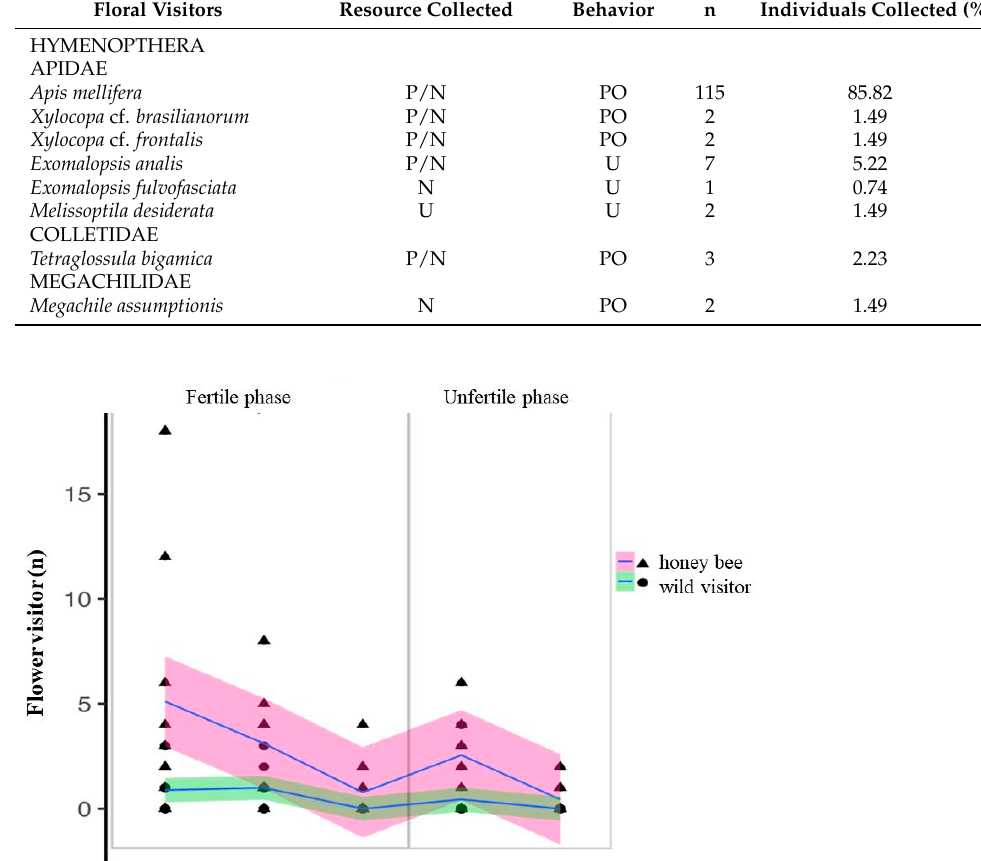
Table 1. Type of resource collected, behavior and percentage of floral visitors of Ludwigia nervosa .